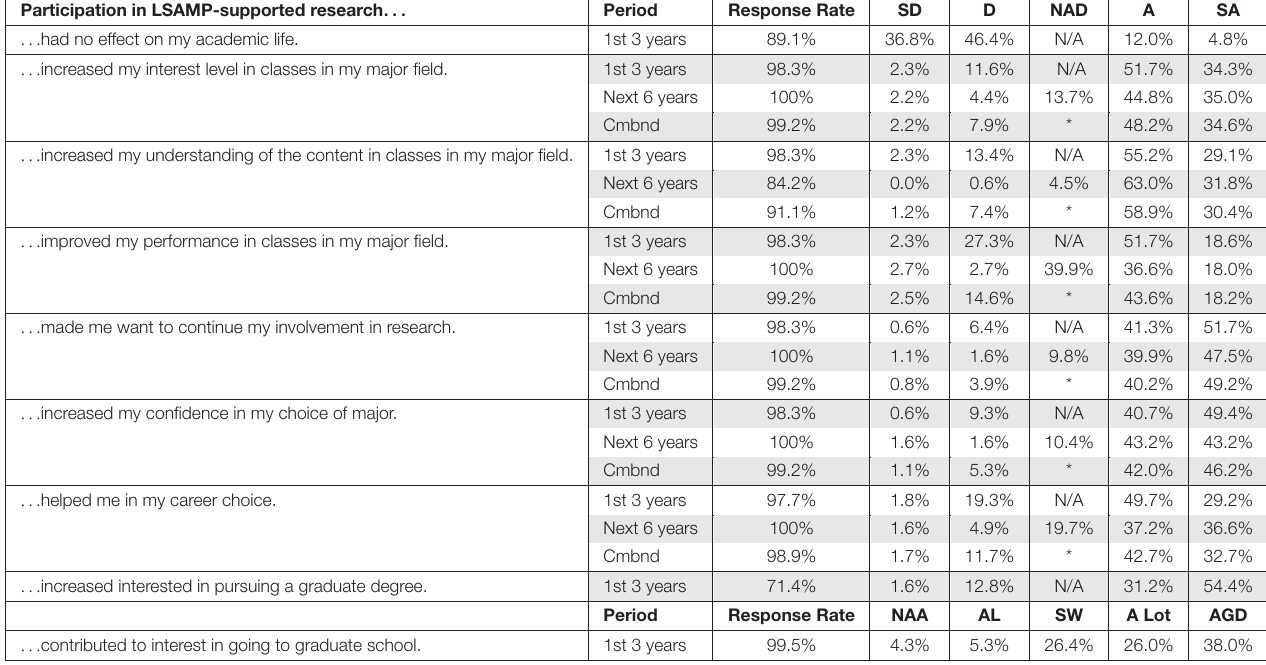
TABLE 1 | Survey responses